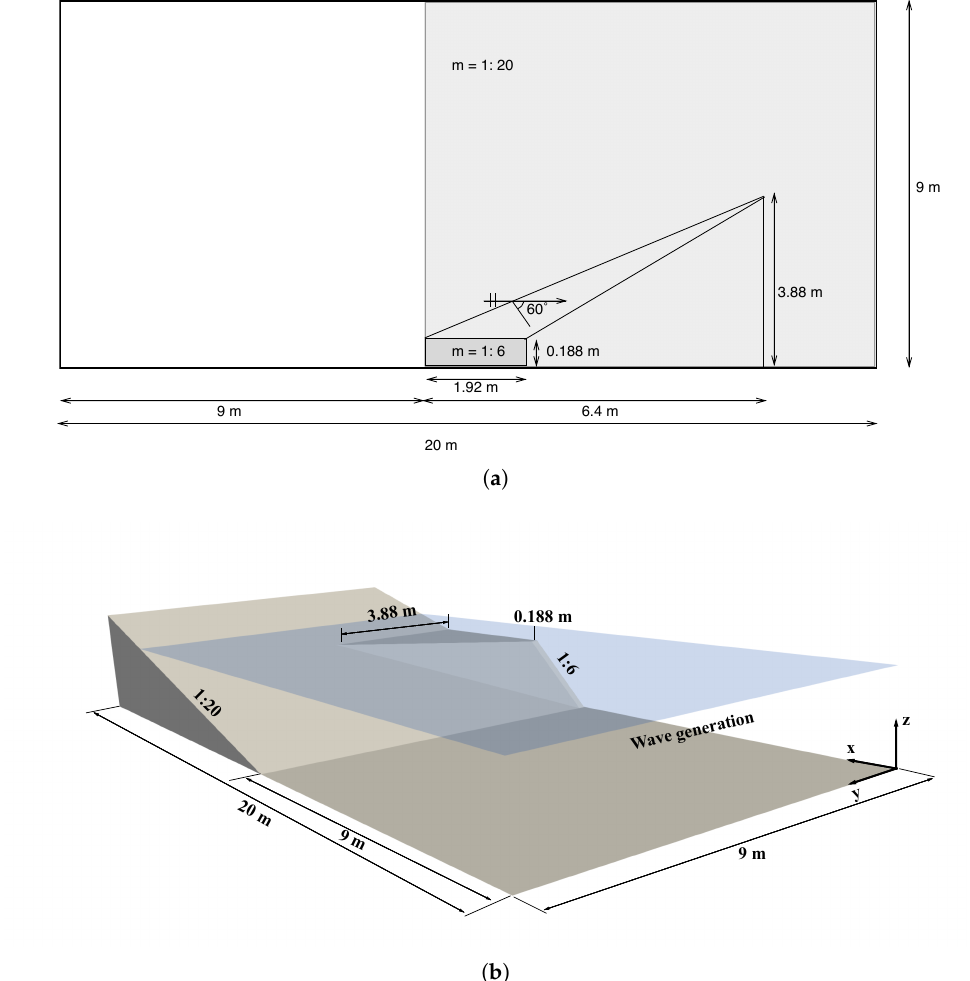
Figure 8. Numerical wave tank setup for the simulation of three-dimensional wave breaking on a reef. m represents the slopes. ( a ) schematics from top view, ( b ) 3D view in the